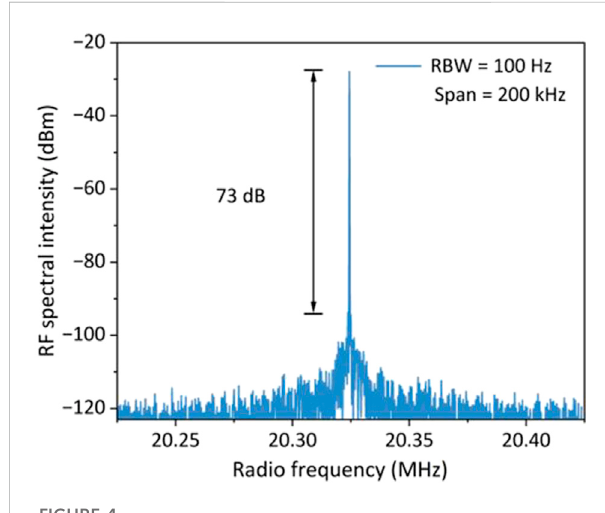
FIGURE 4 Fundamental RF spectrum measured for twelve-pass con fi guration at a resolution bandwidth of 100 Hz showing a signal- to-noise ratio of 73 dB.